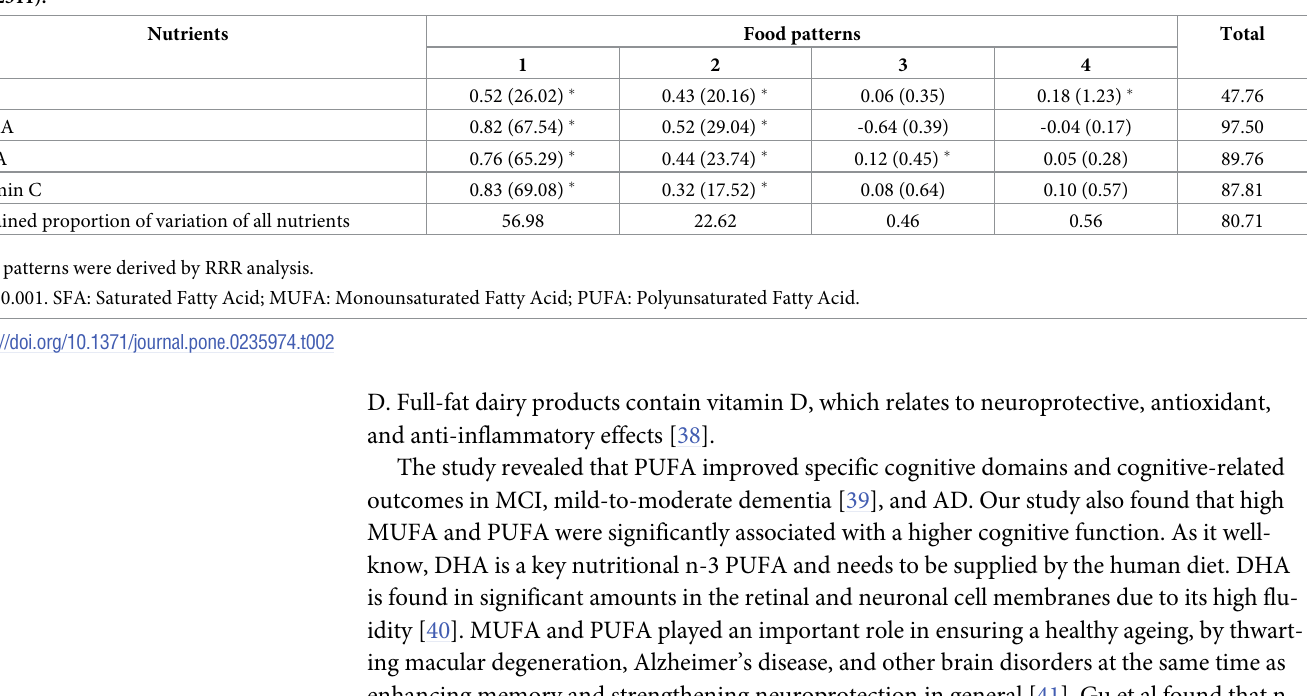
Table 2. Pearson’s correlation coefficients and explained percentage between nutrients (dependent variables) and extracted food patterns (independent variables) ( n = 2311).